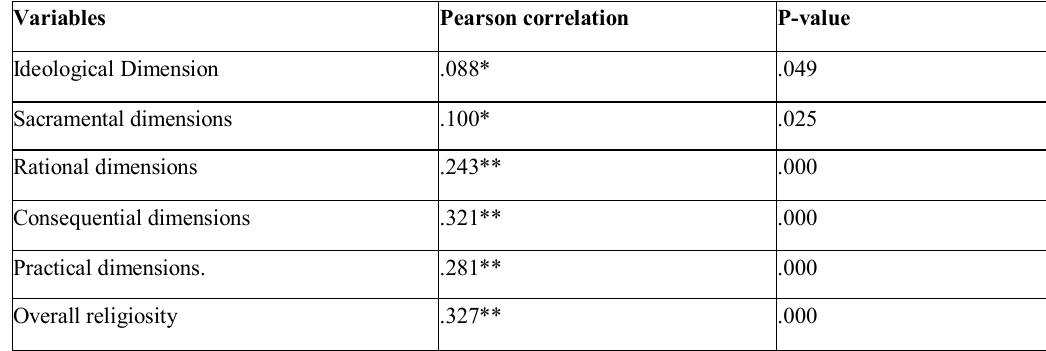
Table V: Dependent variable: New Product